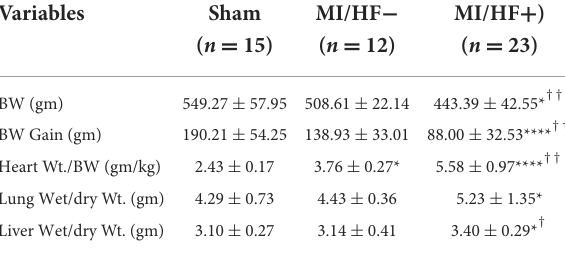
TABLE 2 Anatomical characteristics of different groups.